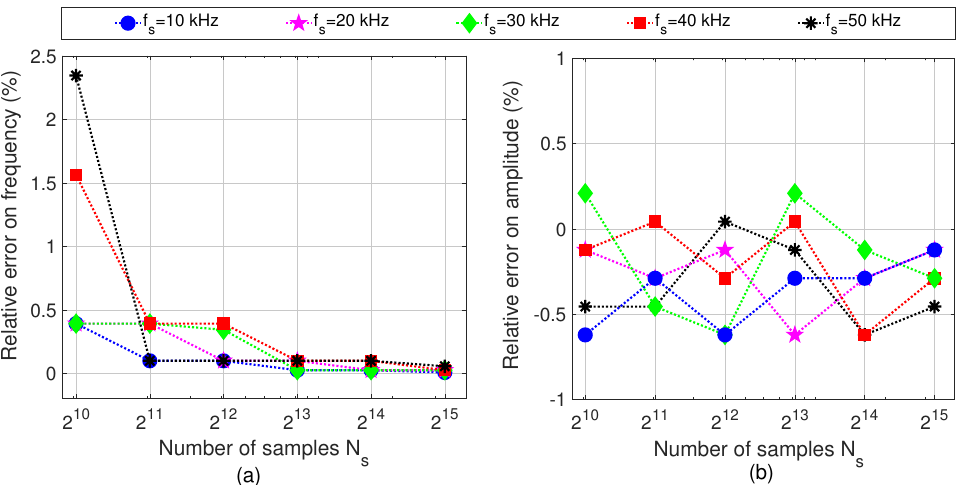
Figure 7. Relative error affecting the ( a ) fundamental frequency and ( b ) amplitude of the input sinusoidal signal, when the top flat window is used.